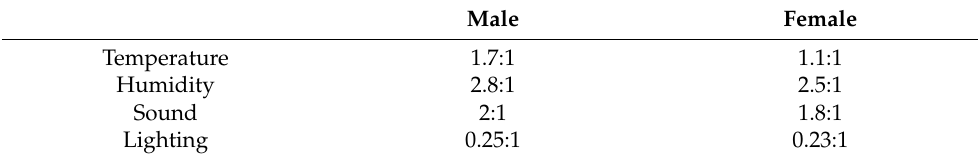
Table 5. Ratio of positive and negative votes according to the different genders.